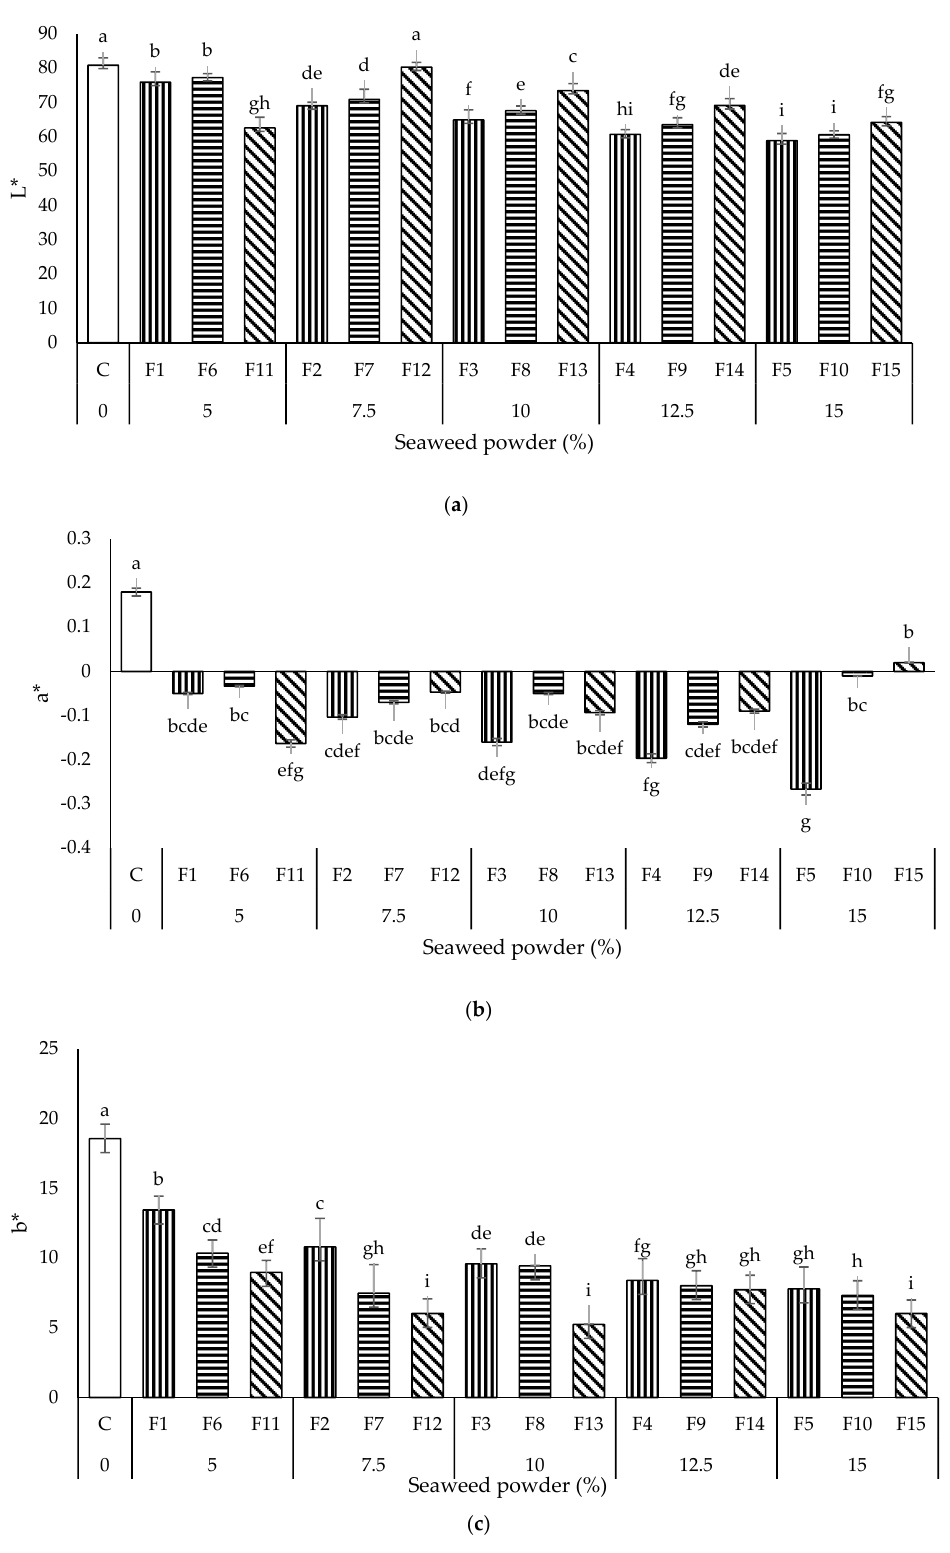
Figure 4. Appearances of all the instant noodles incorporated with seaweed powder and the control noodles (without seaweed powder).